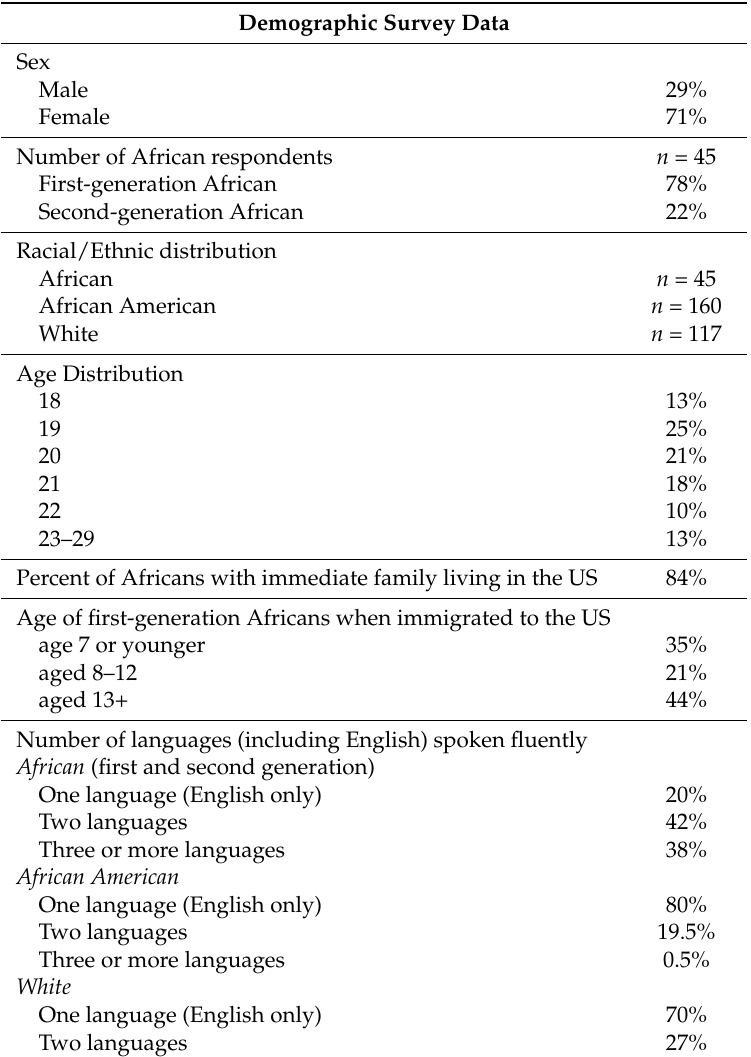
Table 5. Characteristics of Total Sample ( n = 322). Demographic Survey Data